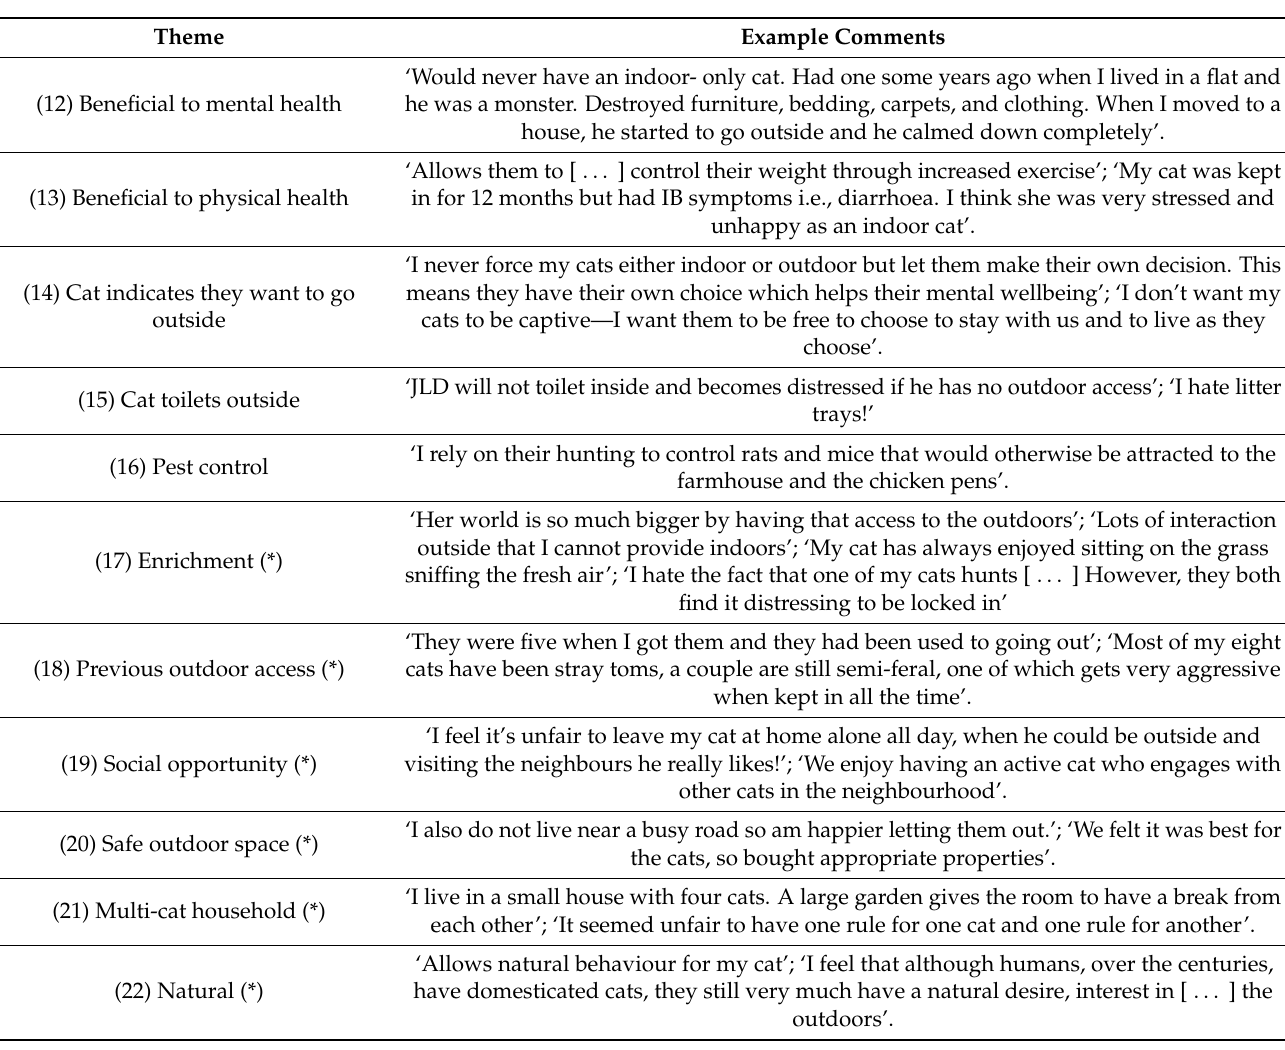
Table 10. Example quotes from owners used to create the 10 indoor-outdoor rationale